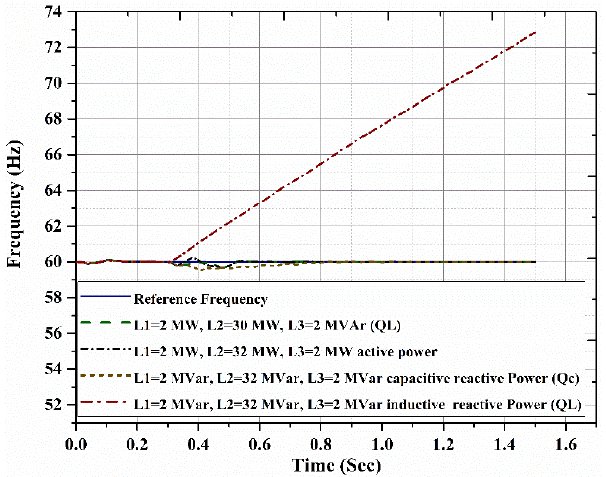
Figure 17. The frequency variations during islanding conditions of scenario 3 in different configuration of the connected feeder loads.